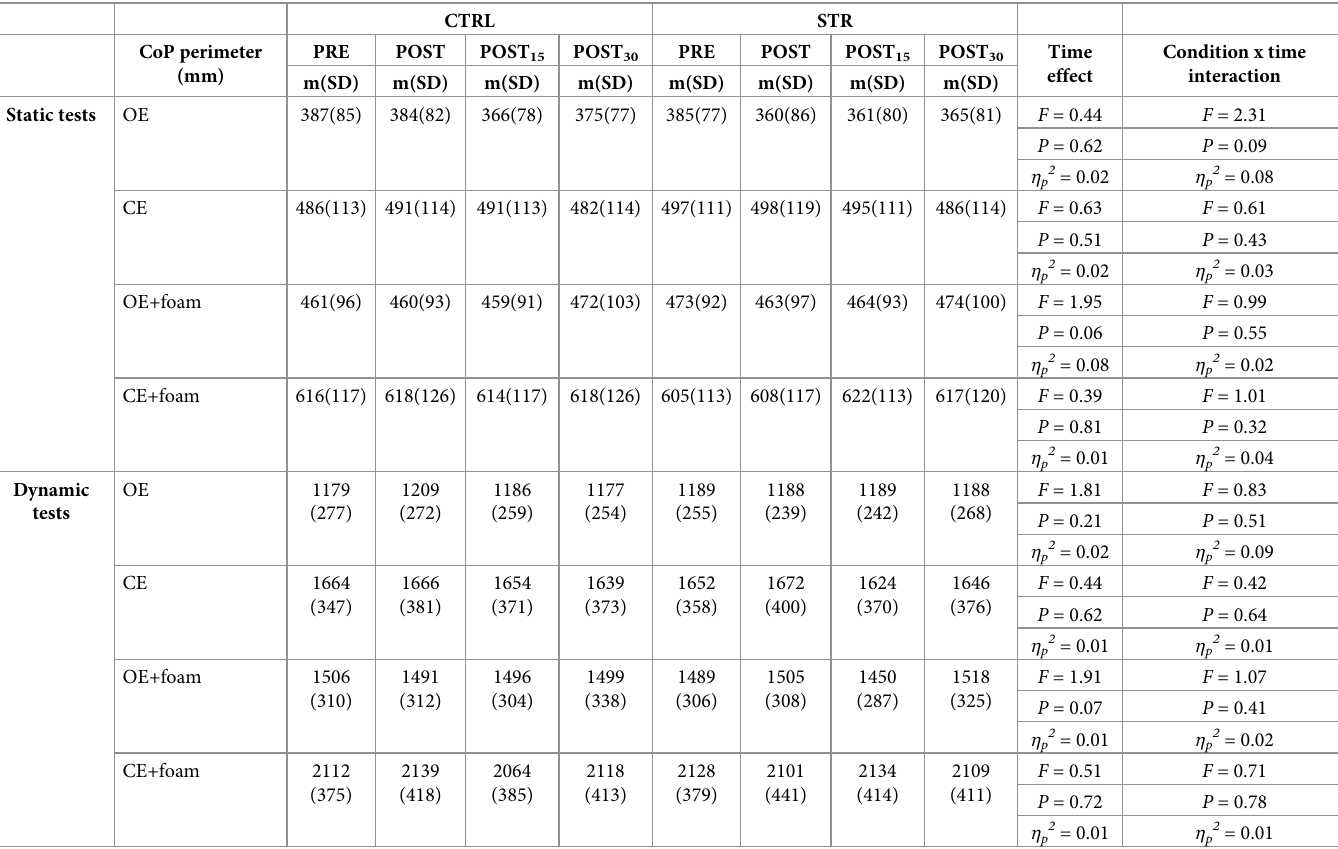
Table 4. Time course of centre of pressure (CoP) perimeter in the control (CTRL) and stretching session (STR) during the static and dynamic